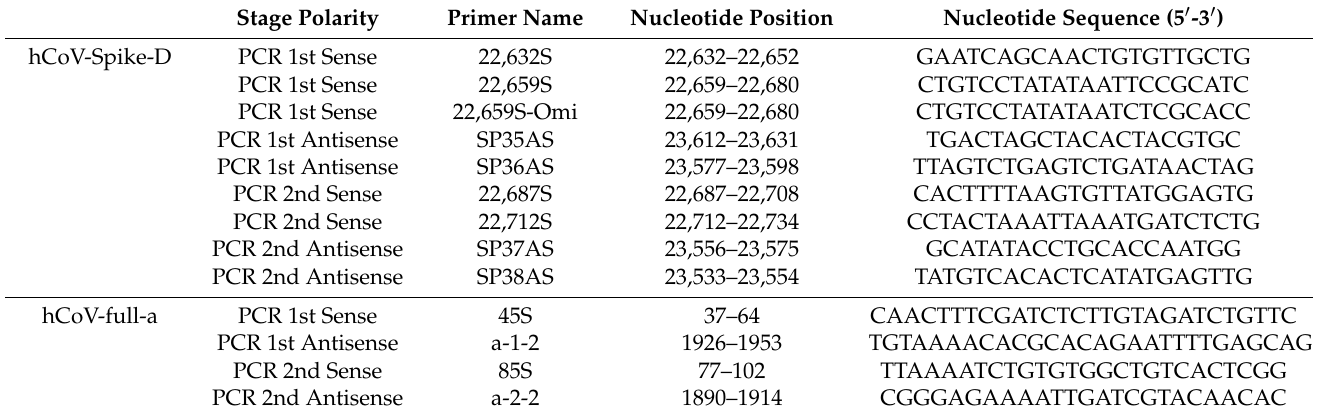
Table 1. In-house-developed specific primers used for nested RT-PCR of SARS-CoV-2 virus. Stage Polarity